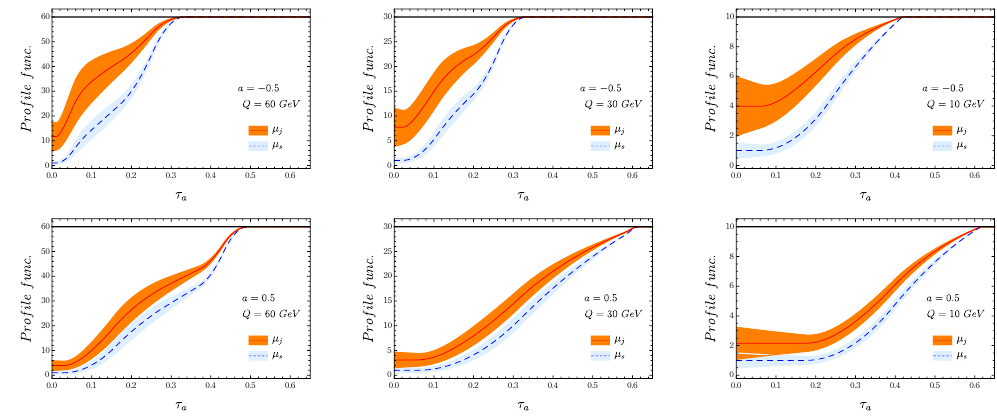
Figure 7 . Modified profile functions for Q = 60 , 30 , 10 GeV at a = − 0 . 5 , 0 . 5 . Red line with orange colored uncertainty represents µ J,B and µ S is shown in blue line with light-blue uncertainty